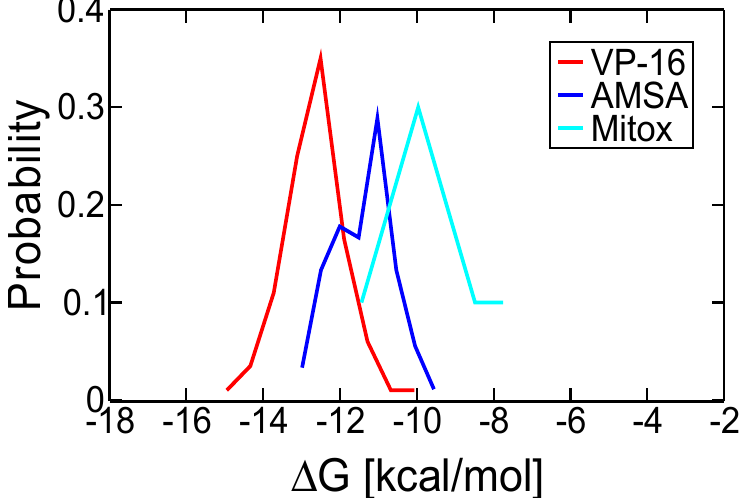
Figure 2. Free energy spectra of VP-16, m -AMSA and mitoxantrone for the TOP2- β cleavage